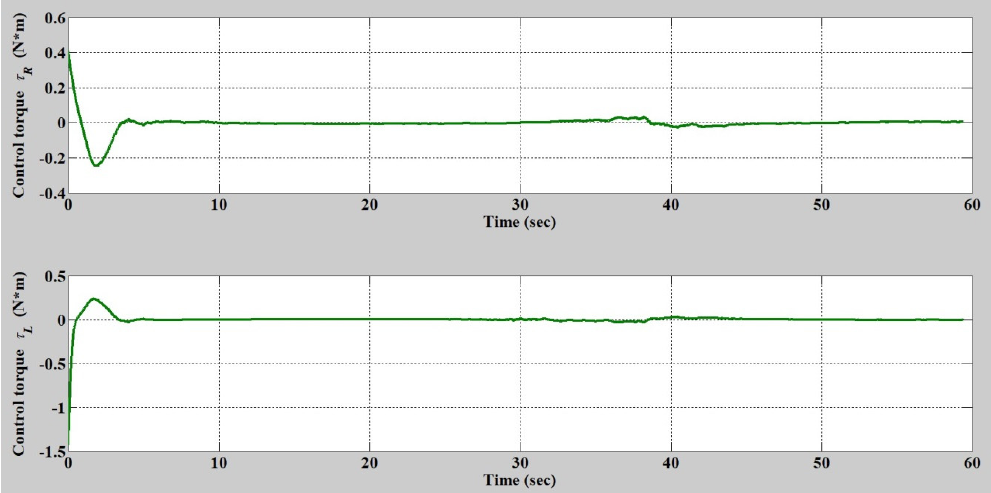
Figure 17. Results of S-type trajectory tracking torques concerning initial point ( x c = − 1.9 m, y c = 0 m).